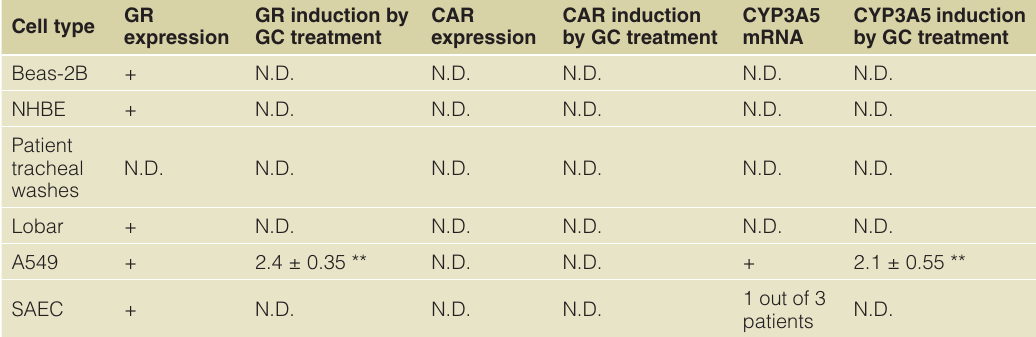
Data are represented as fold over DMSO control. Statistics used for data analysis were one-way ANOVA with Dunnett’s post-hoc test. ** p<0.01, N.D. = not detected, GC =